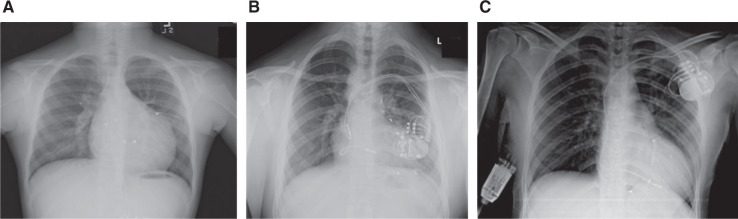
Chest X-rays showing variations of configurations for CRT in pediatric patients. A: Epicardial configuration. B: Transvenous configuration. C: Hybrid approach with LV lead tunneled from the epicardium.